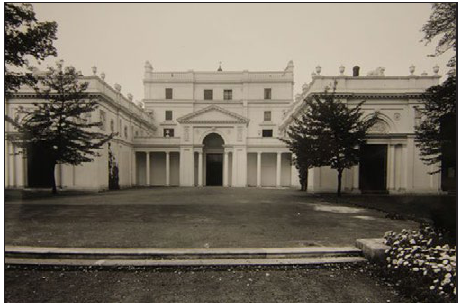
Figure 3: The Institute of Archaeology,